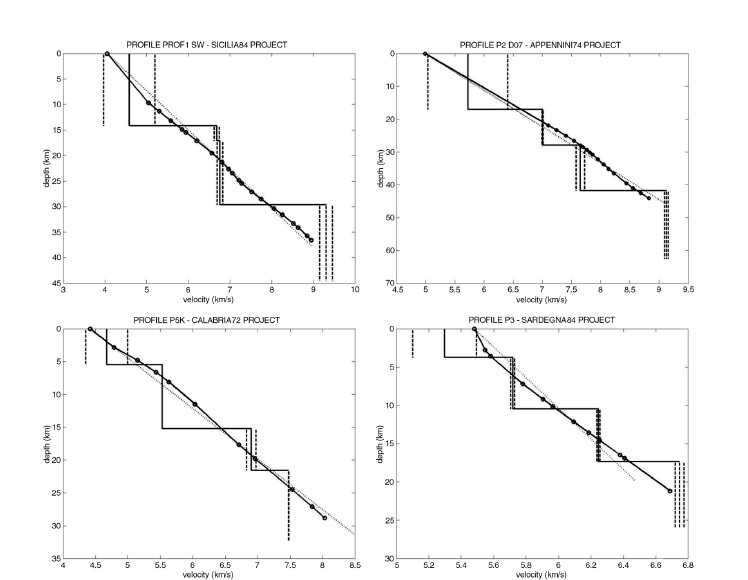
Fig. 7. Examples of velocity-depth functions calculated for four of the seismic sections of the database. The dotted line and the solid line with circles represent respectively the constant gradient and the variable gradient models; the solid and the dashed lines represent the constant-velocity layered model and its limits of